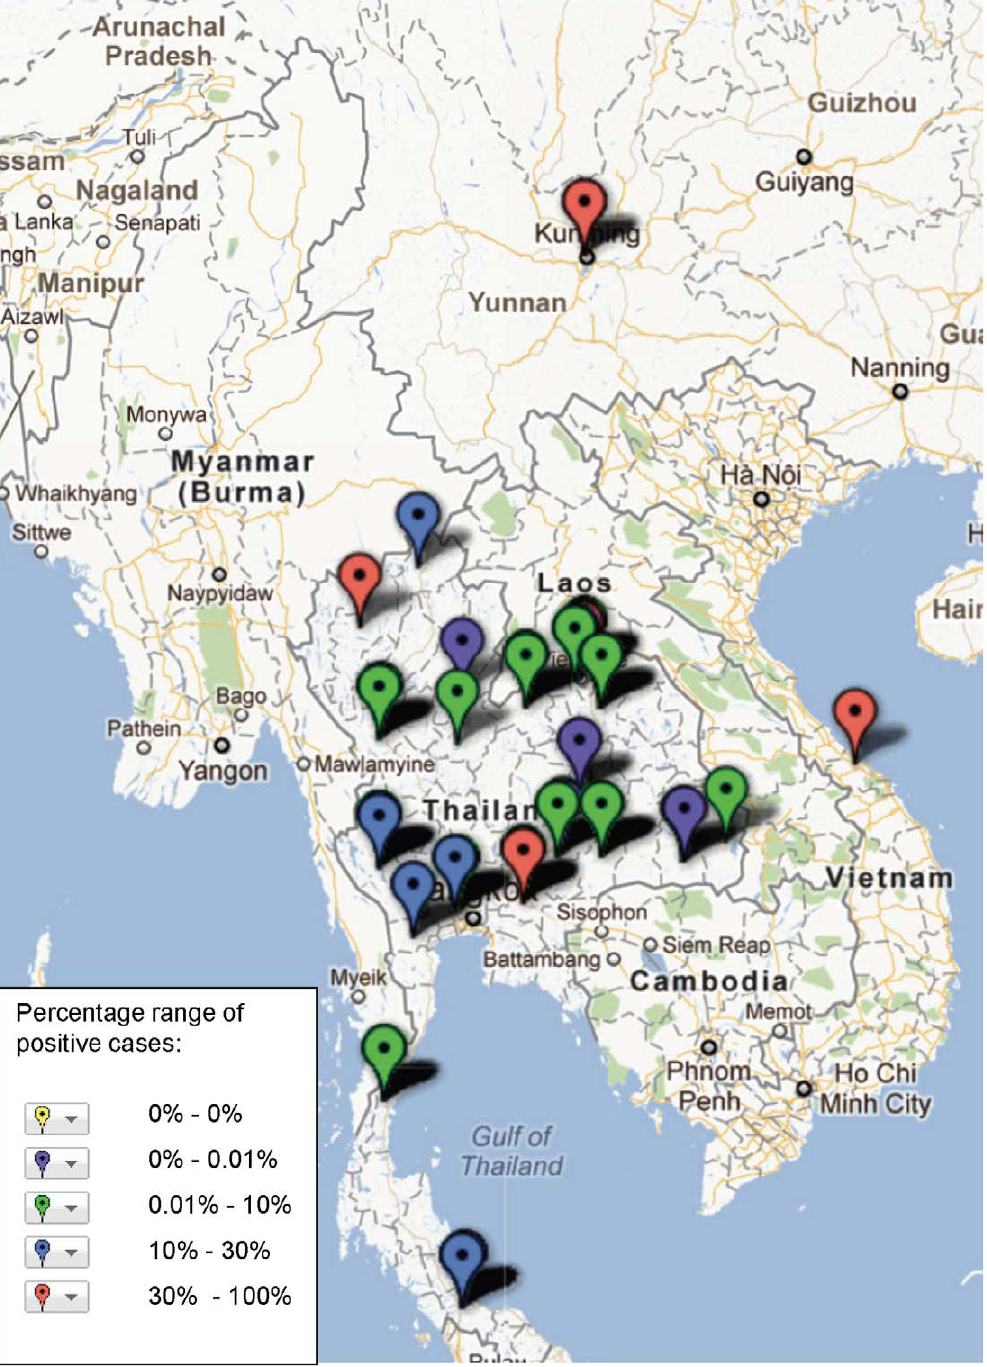
Figure 8. Study sites in the Mekong region where Rickettsioses have been reported, illustrating frequency of identification (case) based on assays and sample population used in the study (see Table